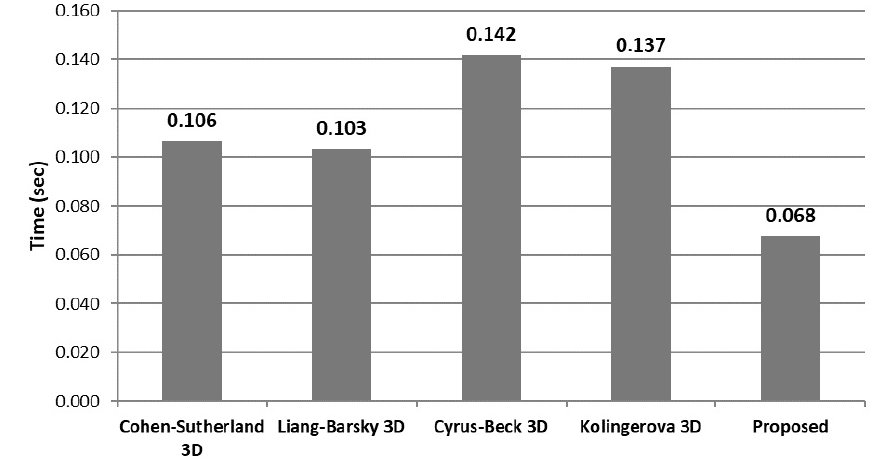
Figure 19. Average time of each algorithm when clipping one million lines (lower is